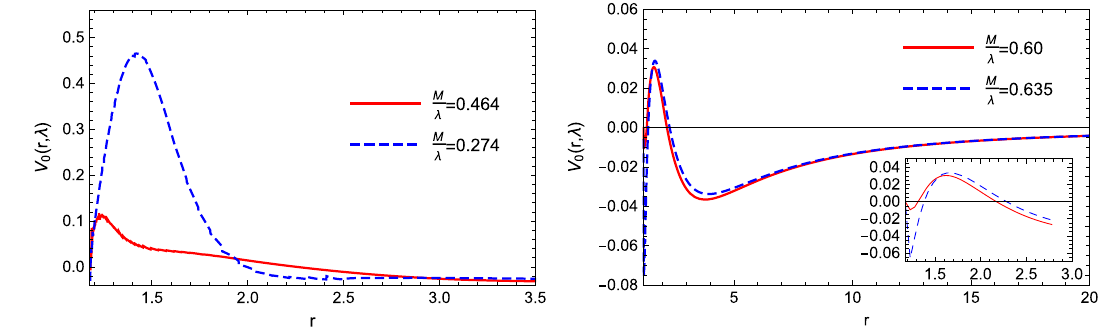
Fig. 8 Twoscalarpotentialgraphsof V 0 ( r ,λ) for s -modescalararound the n = 0blackholewithhorizonradius r + = 1 . 174.(Left)exponential coupling.(Right)quadraticcoupling.Themagnificationoftheenclosed